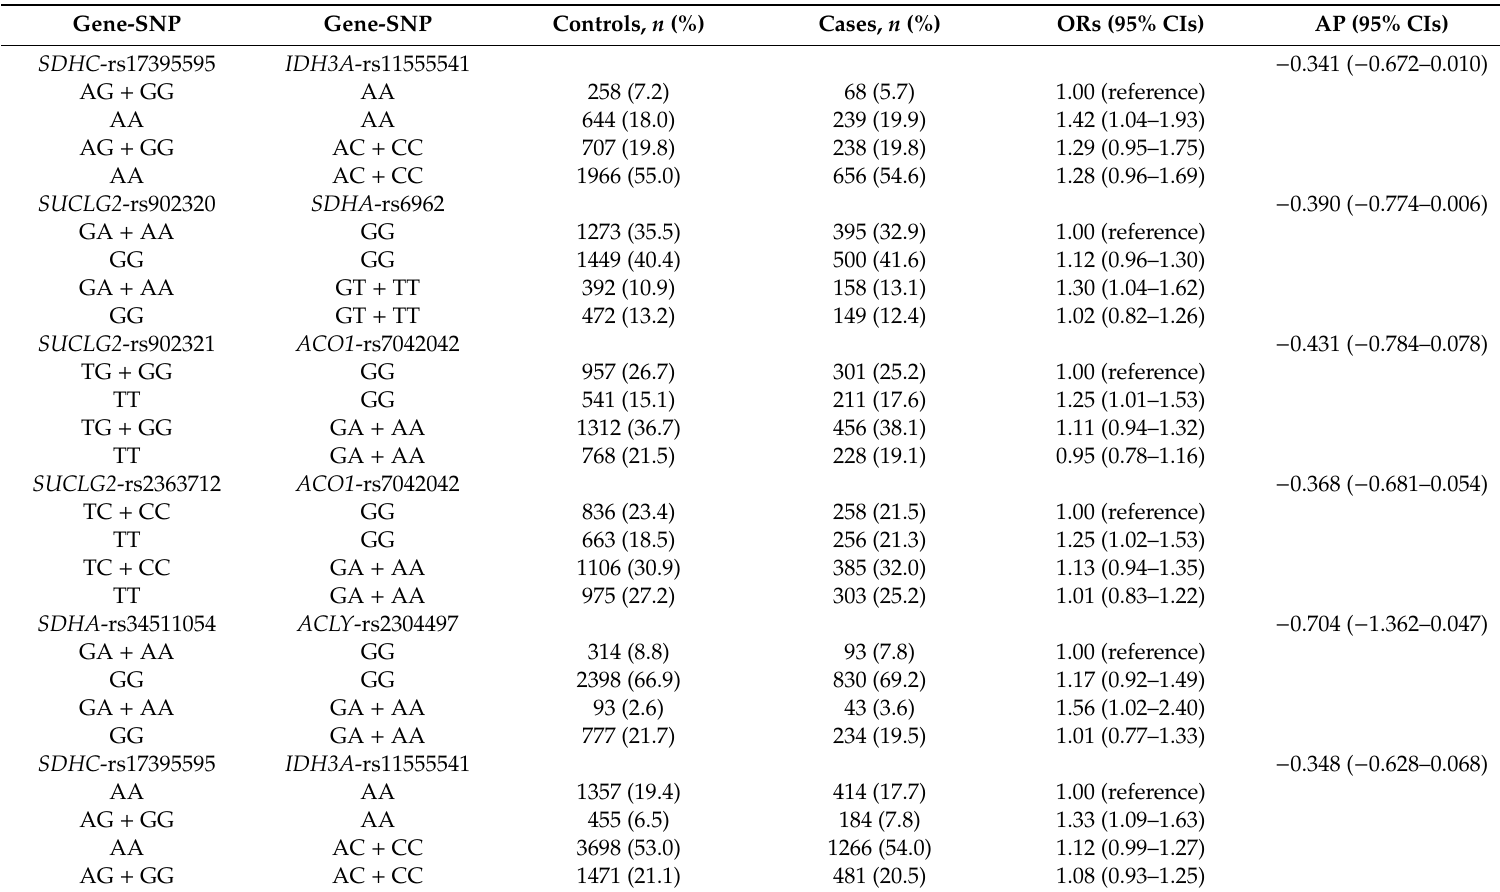
Table 7. Odds ratios (OR) and 95% confidence intervals (CIs) for the combined e ff ect of the citric acid cycle SNPs on the risk of colon cancer, showing the 95% CIs of AP not containing